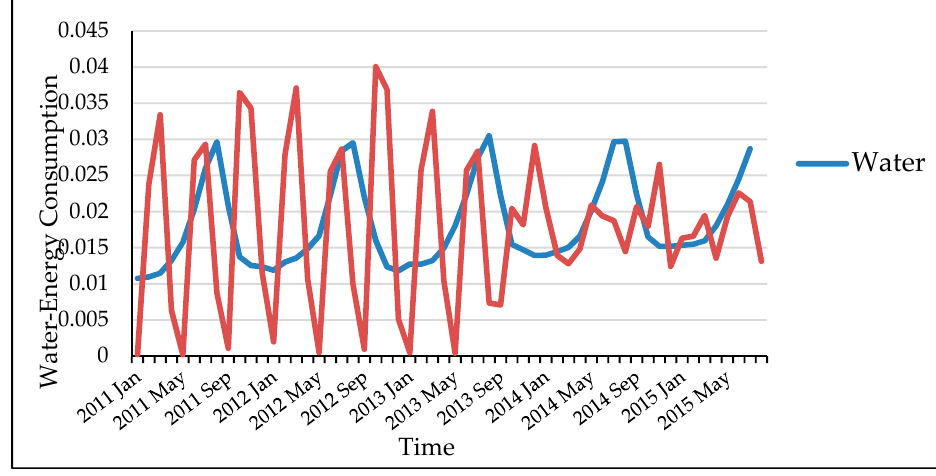
Figure 2. The consumption behavior of water in relation to domestic energy